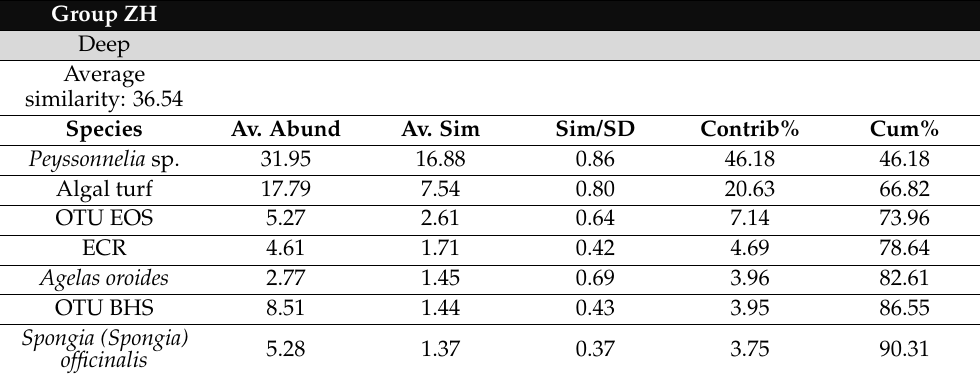
Figure 6. Redundancy analysis (RDA) plot showing the relationship between coralligenous biocon- structions based on the covering values of the associated macrobenthic taxa and environmental variables (depth and site). Sets of different colors include samples with different similarity levels. ZH = Zhapovel Bay, DH = Cape of Dhim Kushta, HA = Haxhi Ali Cave, WE = Cape of Gjuhezes, S = shallow replicates, and D = deep replicates. R 2 : 0.1013, and P(Perm): 0.001. Table 4. Similarity percentage (SIMPER) analysis with a 90% cut-off criterion for species showed the taxa that contributed most as discriminant components between sites and depths.